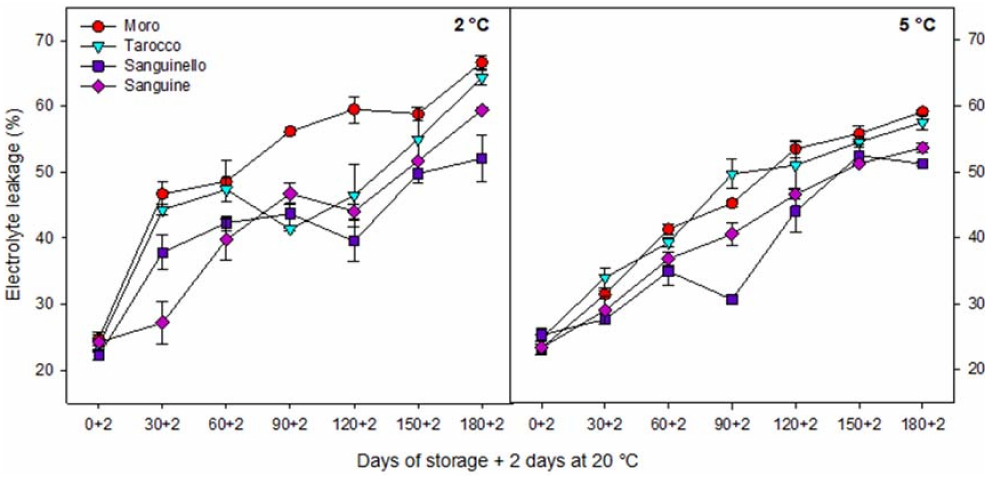
Figure 1. Chilling injury (CI) index and electrolyte leakage (EL) of blood orange cultivars (‘Moro’, ‘Tarocco’, ‘Sanguinello’ and ‘Sanguine’) during 180 days of cold storage at 2 and 5 ◦ C and 90% relative humidity (RH) and 2 days at 20 ◦ C. Vertical bars represent ± standard error (SE) of means. Least significant di ff erence (LSD) ( p < 0.05) value is 0.18 for CI and 5.17 for